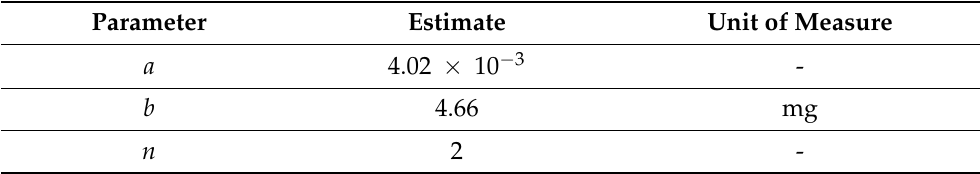
Table 3. Parameter estimates of the toxicity function in Equation